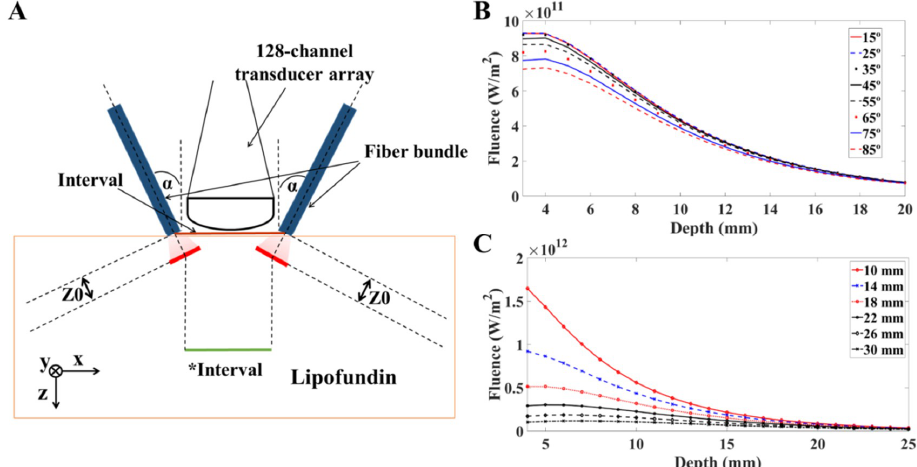
Figure 3. Schematic and simulation results of fluence in 1% Lipofundin. The simulated laser source was a short pulsed (5 ns pulse width), high-energy (20 mJ per pulse) laser, with Gaussian energy distributed temporally. The output beam dimensions of each fiber bundle arm were 16.5 mm × 0.8 mm. ( A ) The simulation configuration for light transmission in 1% Lipofundin. α is the incident angle of the light sources. Z0 is the transport mean free path. Within the distance of Z0 , photons propagate in their original directions with negligible scattering events. The Interval is the distance between the two arms of fiber bundle, while the *Interval is the distance between the central points of the red lines (i.e., the light starts to propagate in the diffusive regime). The detector is a 128-channel transducer array. The interval and incident angle are the two main factors included for evaluation. ( B ) The changes in light fluence with respect to different incident angles. The interval was fixed at 14 mm. The light fluence decreased with increasing incident angles. However, the differences in light fluence were minimal when the angle ranged from 15 degrees to 35 degrees. ( C ) The changes in light fluence with respect to different intervals between the two arms of the fiber bundle. The incident angle was fixed at 35 degrees. The fluence value decreased dramatically with an increasing interval from 10 mm to 30 mm. The fluence difference was also reduced as the light propagated deeper into the medium. The results indicated that two arms need to be placed as close together as possible to reach a higher fluence